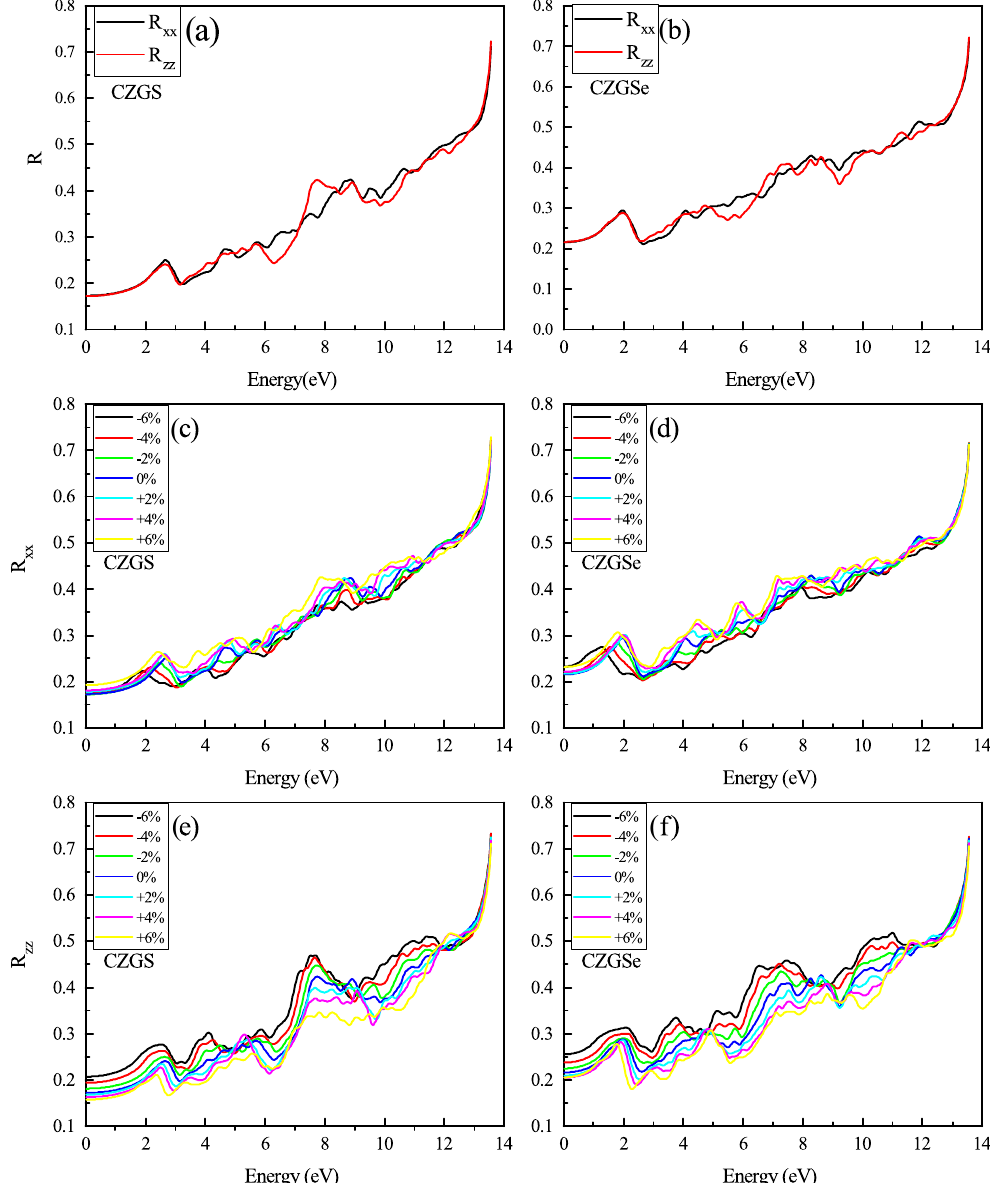
Figure 12. The variation of the reflectivity spectra as a function of the incident photon energy for both materials CZGS and CZGSe: ( a , b ) are the unstrained cases, ( c – f ) are the strained cases. R xx and R zz are the reflectivities for light polarization along XX and ZZ directions